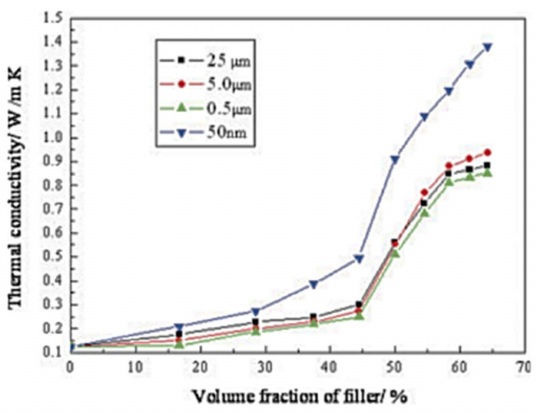
Figure 7. Effect of Al 2 O 3 particle size on the thermal conductivity of silicone rubber nanocomposites